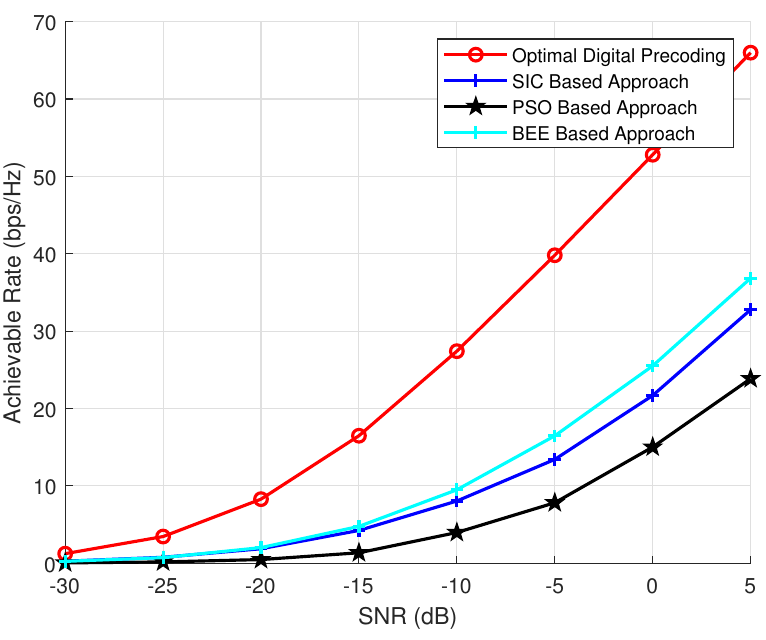
Figure 5. Simulations using N T = 256, N R = 36, N rf =